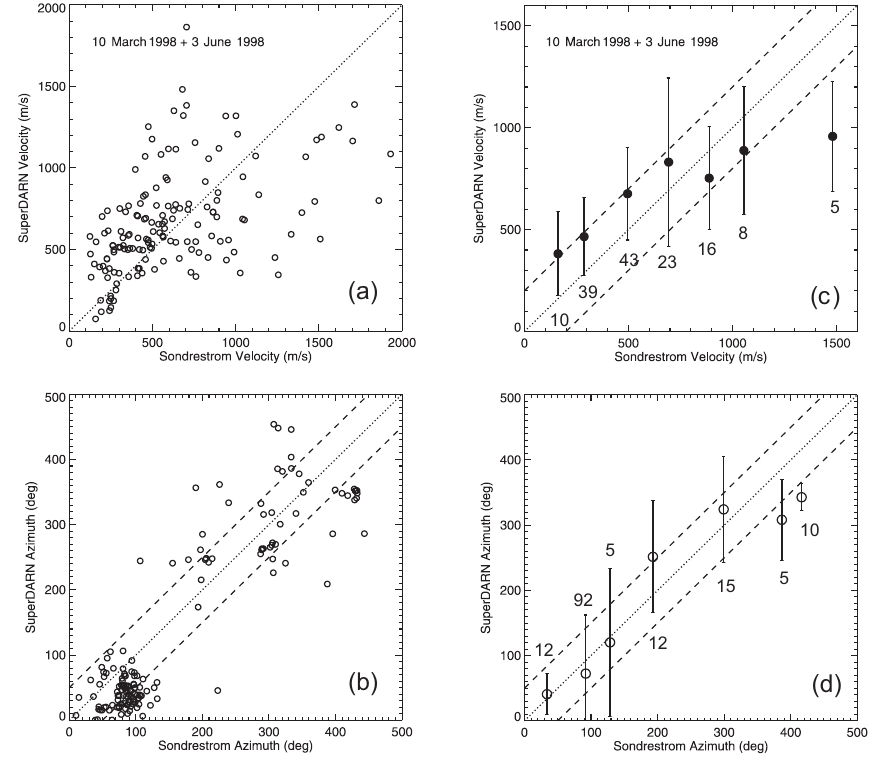
Fig. 9c indicate a SuperDARN/Sondrestrom velocity differ- ence of 200 m/s. For the convection azimuth, differences are mostly within ± 50 ◦ (shown by dashed lines in panel